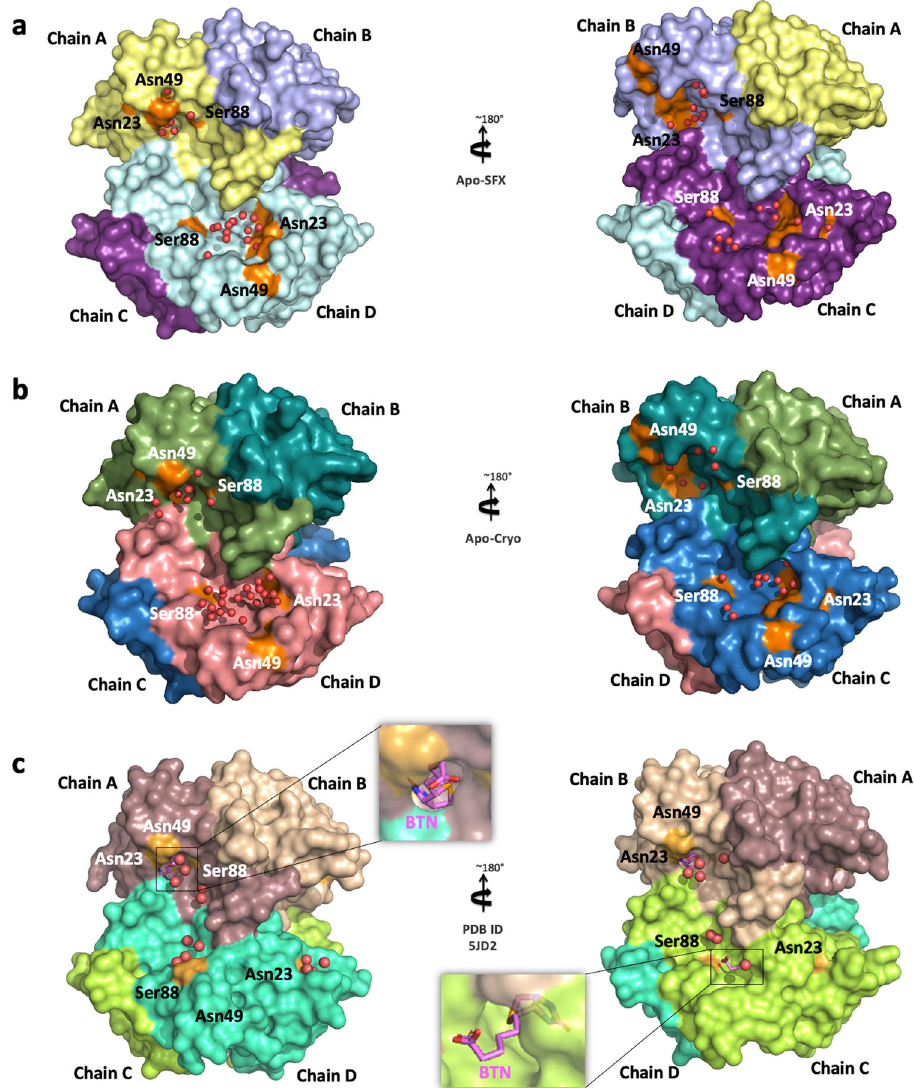
Fig. 4 Representation of water molecules in the binding pocket of streptavidin structures. a Apo-SFX structure and b Apo-Cryo structure of apo-state streptavidin and c Holo-SFX structure with selenobiotin (BTN) (PDB ID: 5JD2) are shown with their surface and water molecules are shown with red spheres. The indicated residues around the binding pocket are shown in orange